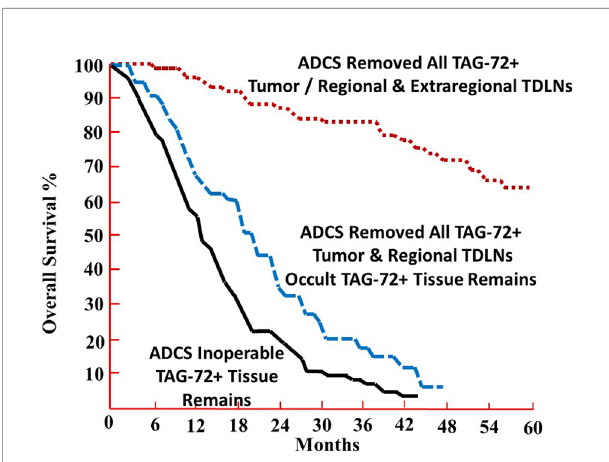
FIGURE 3 | The 5-year overall survival (OS) percentage of patients undergoing TAG-72 antigen-directed cancer surgery. The 5-year OS of 212 patients with recurrent or primary colorectal carcinoma was injected with murine monoclonal antibody (mMoAb) 125 I-B72.3 or 125 I-CC49 (37). Complete removal of all TAG-72-positive tissue provides a highly signi fi cant 5- year OS advantage when compared to those patients with retention of grossly evident tumor and TAG-72-positive tissue (p < 0.0001) (black line) or occult TAG-72-positive tissue (no residual grossly evident tumor) (p < 0.0025) (blue dashed line) upon completion of